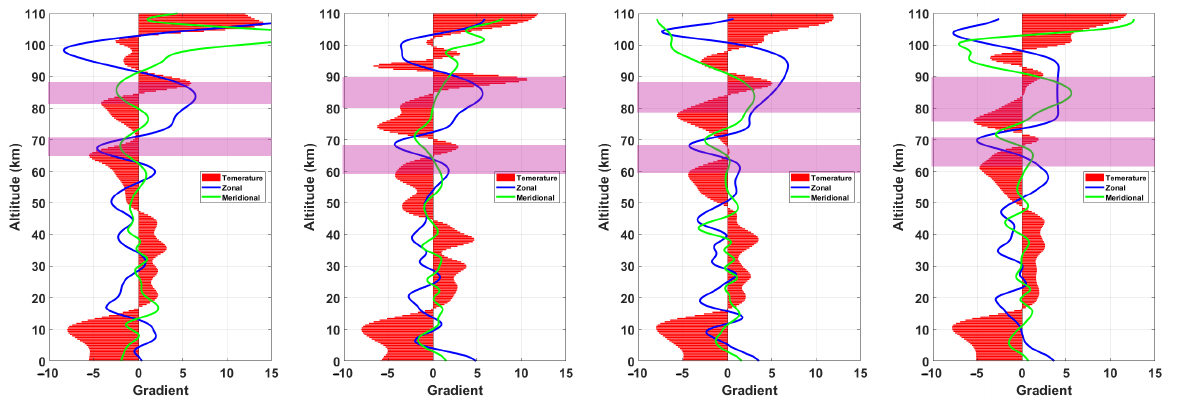
Figure 8. Profiles of gradients of temperature (red), zonal wind (blue), and meridional wind (green). Purple highlighted region represent regions in the mesosphere where the temperature gradient was becoming more positive. From left to right, the panels present the nights of D-3, D-1, D+0, and